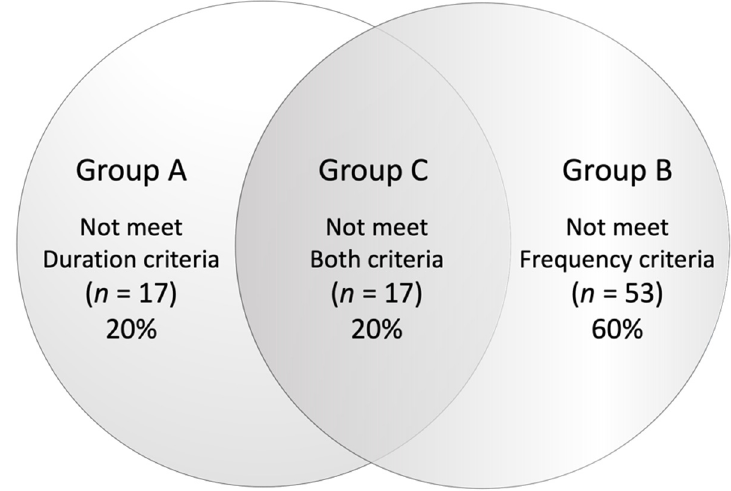
Figure 2. Subdivision of non-FD patients.